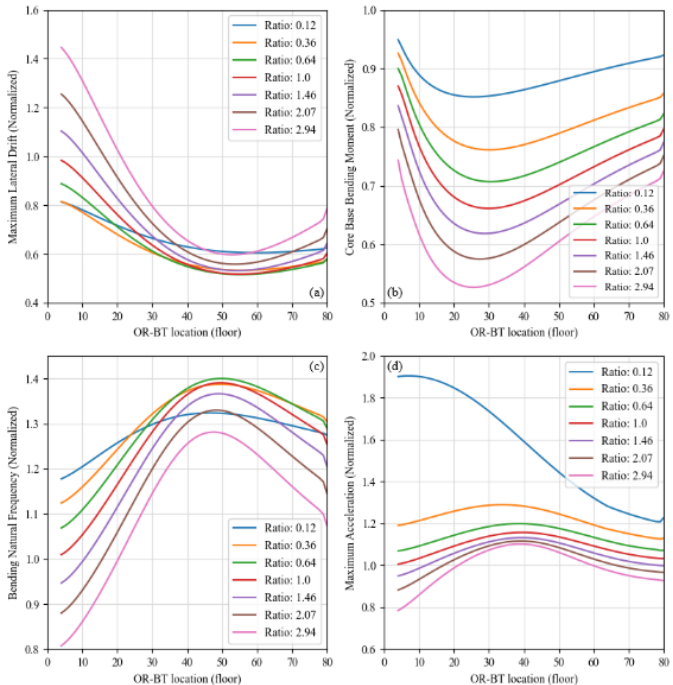
Figure 9. Influence of the column-core stiffness ratio on the optimum location to (a) MLD (b) CBM (c) Bending nat. freq. (d) Max.